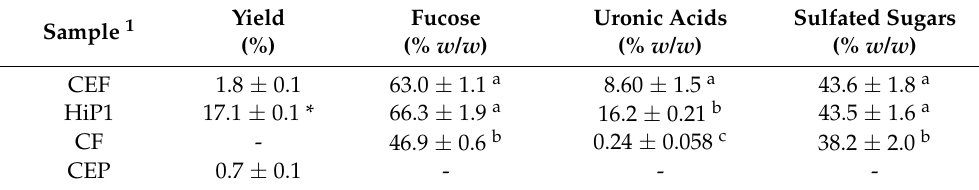
Table 1. Yield extraction for extracts and sugar content contents for extracts of S. filipendula . Sample 1